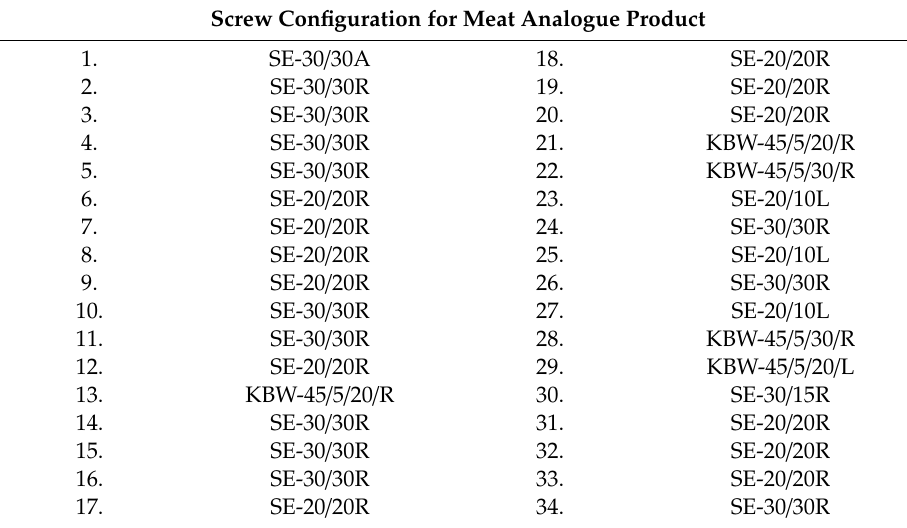
Table A1. Screw configuration used for extrusion of HMMA in this study 1 . Screw Configuration for Meat Analogue